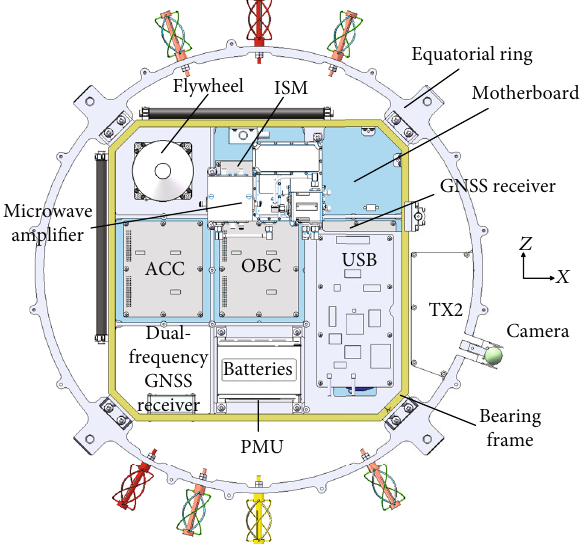
Figure 2: Devices distributed inside Q-SAT.